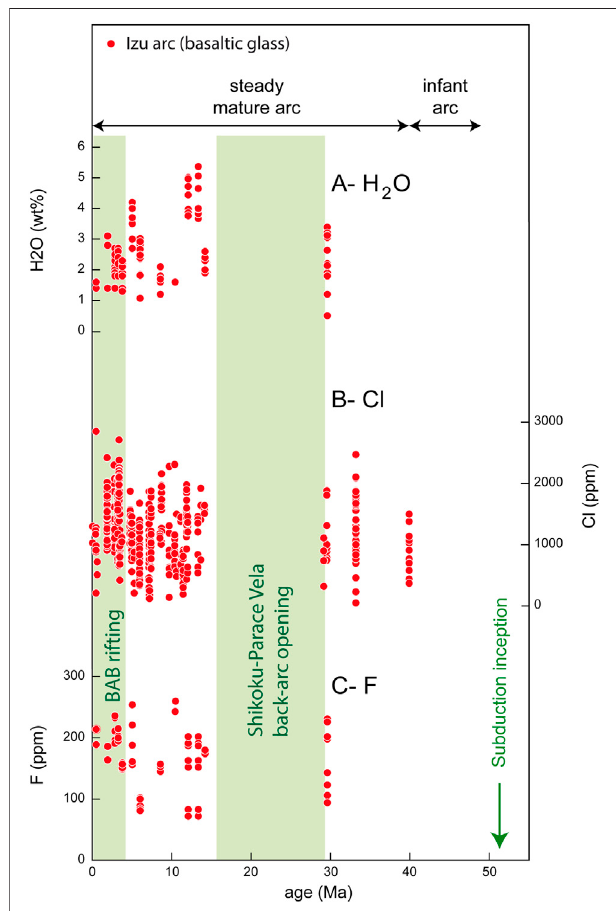
FIGURE 4 | Volatile contents over time. (A) H 2 O (wt%), (B) Cl (ppm), (C) F (ppm) contents of the Izu basaltic glass shards vs. time. Thick green lines from 0 to ~5 Ma and from 15 to 29 Ma depict the opening of the back-arc rift and Shikoku Basin, respectively. A gap in is observed during opening of the Shikoku back-arc Basin, suggesting that the basaltic magmatic activity was interrupted during that interval of time. BAB: back-arc basin.